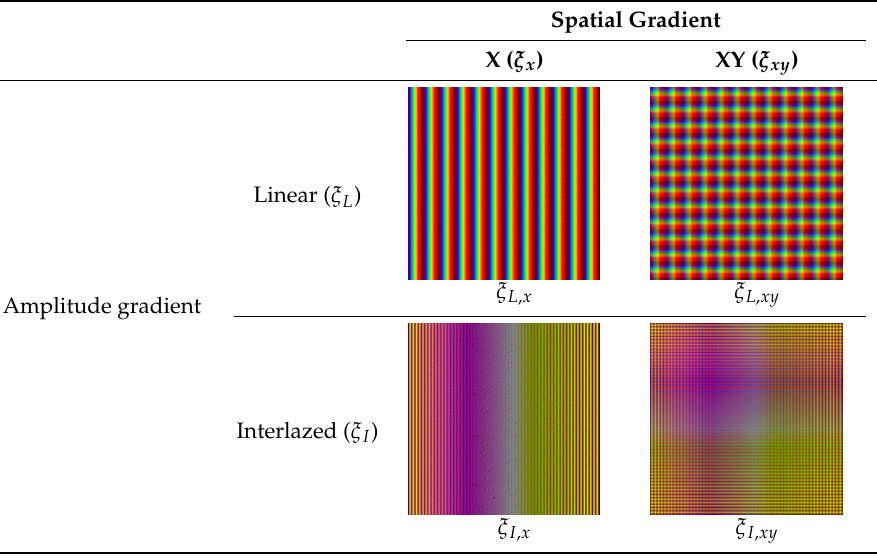
Table 2. Lighting configuration using combinations of the spatial and amplitude